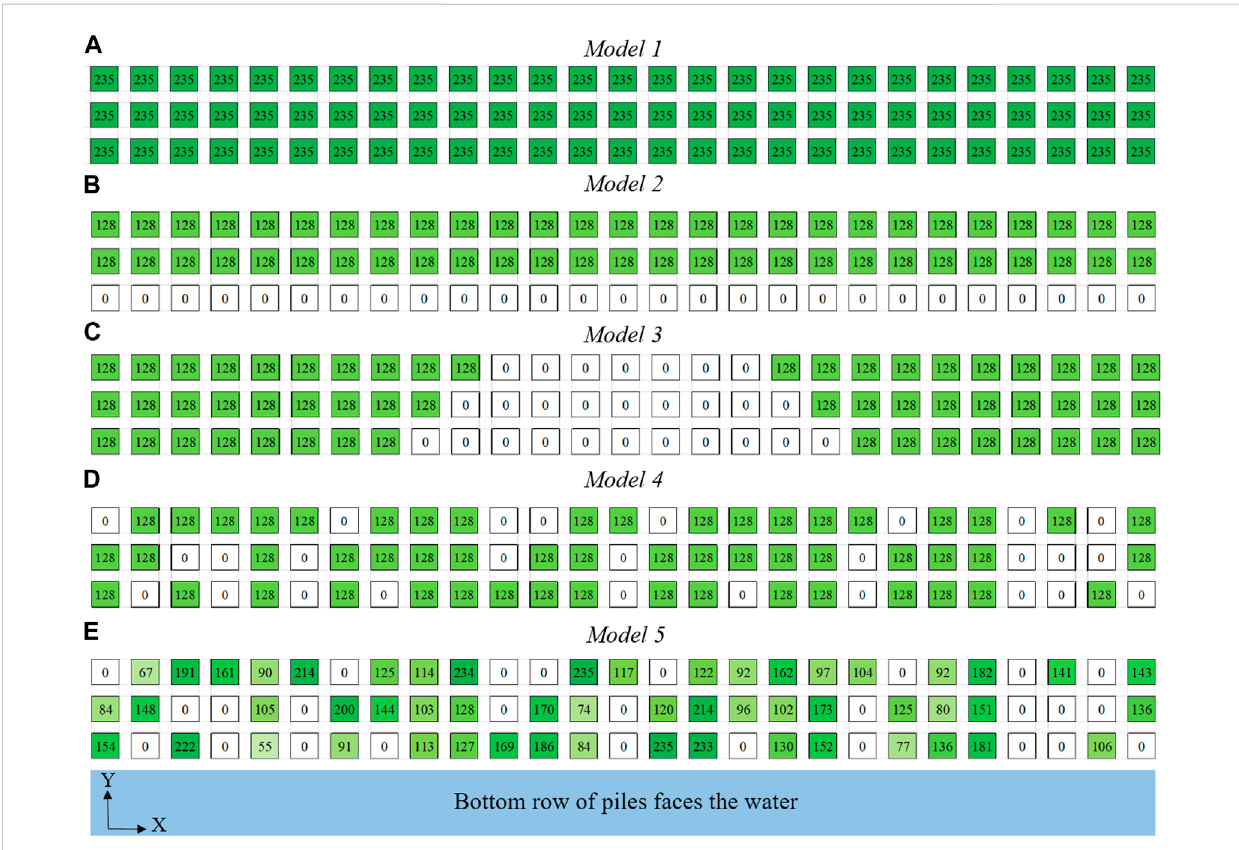
Frontiers in Built